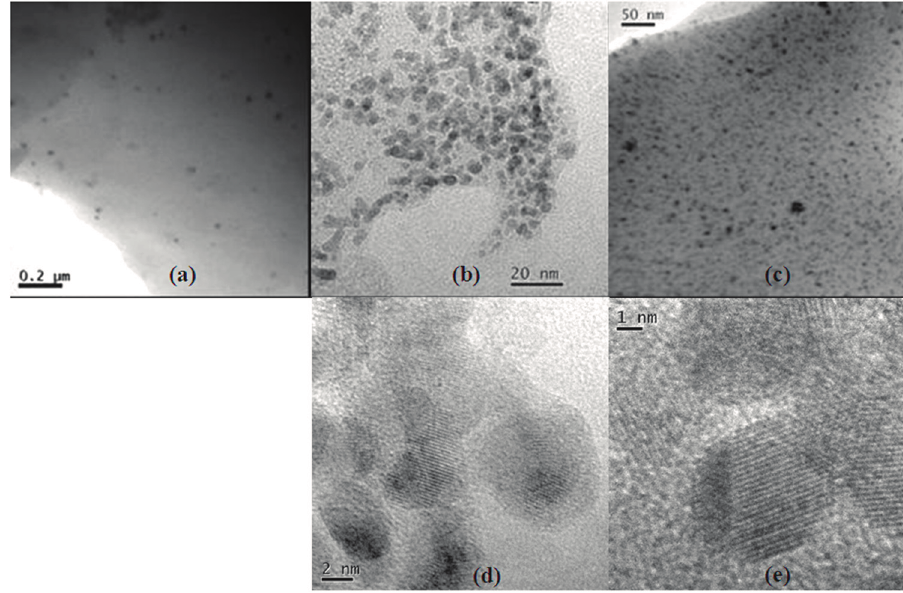
Figure 8. TEM images of Pd-pol ( a ) pristine; ( b ) after the first cycle and ( c ) after the twelfth cycle of nitrobenzene reduction with NaBH 4 , described in Table 2; ( d ) HRTEM image of ( b ) and ( e ) HRTEM image of ( c ).